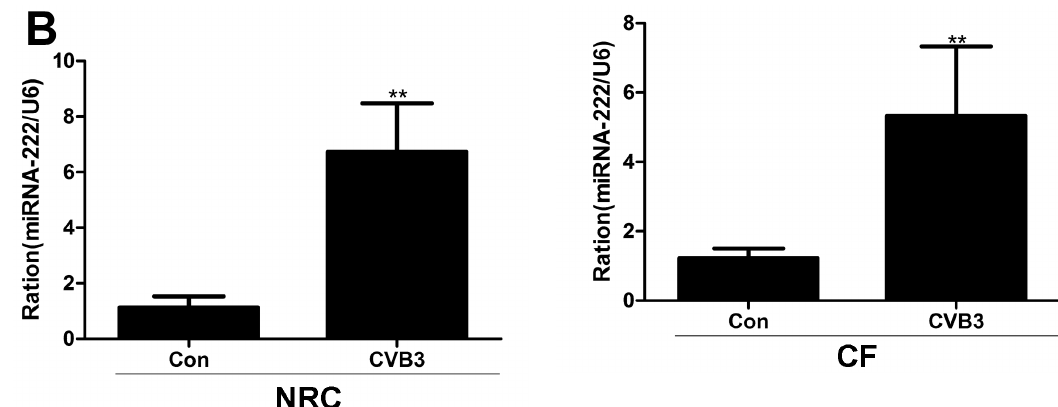
Figure 4. Increased level of miRNA-222 in VMC in the mouse model of VMC and cardiac cell lines infected with CBV3. ( A ) RT-qPCR was used to detect changes inmiRNA-221, -222, -17, -151, and -432, respectively, in myocardial tissue. ( B ) The miRNA-222 of relative quantification was further determined in primary cardiac myocytes and cardiac fibroblasts. Data represent the mean ± SEM from the control (Con) and CVB3-infected groups, ** p < 0.01.